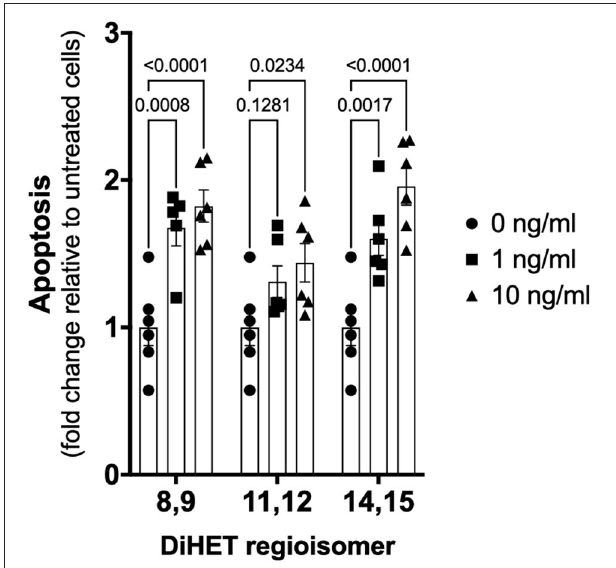
FIGURE 7 | Soluble epoxide hydrolase (sEH)-generated metabolites from arachidonic acid cause chondrocyte apoptosis. Primary equine articular chondrocytes were incubated with the sEH-generated dihydroxy-eicosatrienoic acid (DiHETs) 8,9, 11,12, and 14,15 regioisomers for 24h at the indicated concentrations. Controls (0ng/ml) were treated with vehicle diluent (ethanol; 0.0001% final concentration in culture medium). Apoptosis was determined using ELISA technique as per the manufacturer’s instructions. Data are shown as individual values (symbols) and mean ± SEM (columns), and p -values are shown above each comparison (Two-way ANOVA corrected for multiple comparisons by controlling the False Discovery